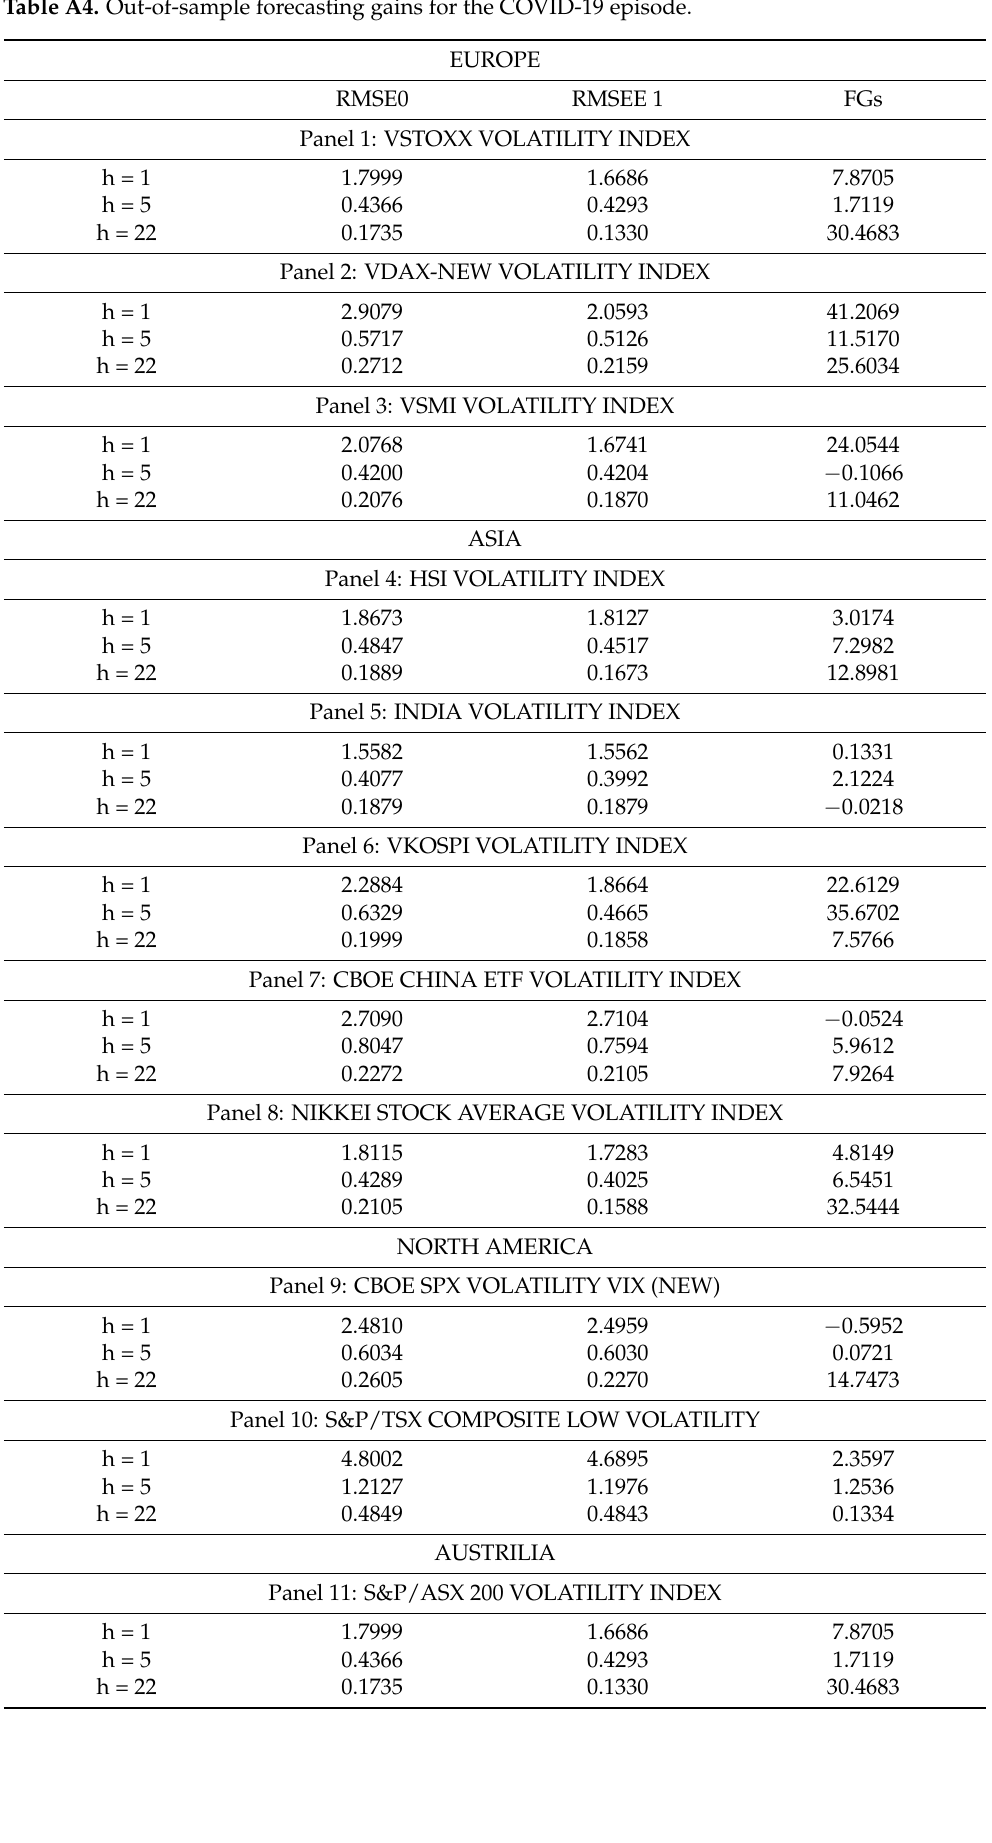
Table A4. Out-of-sample forecasting gains for the COVID-19